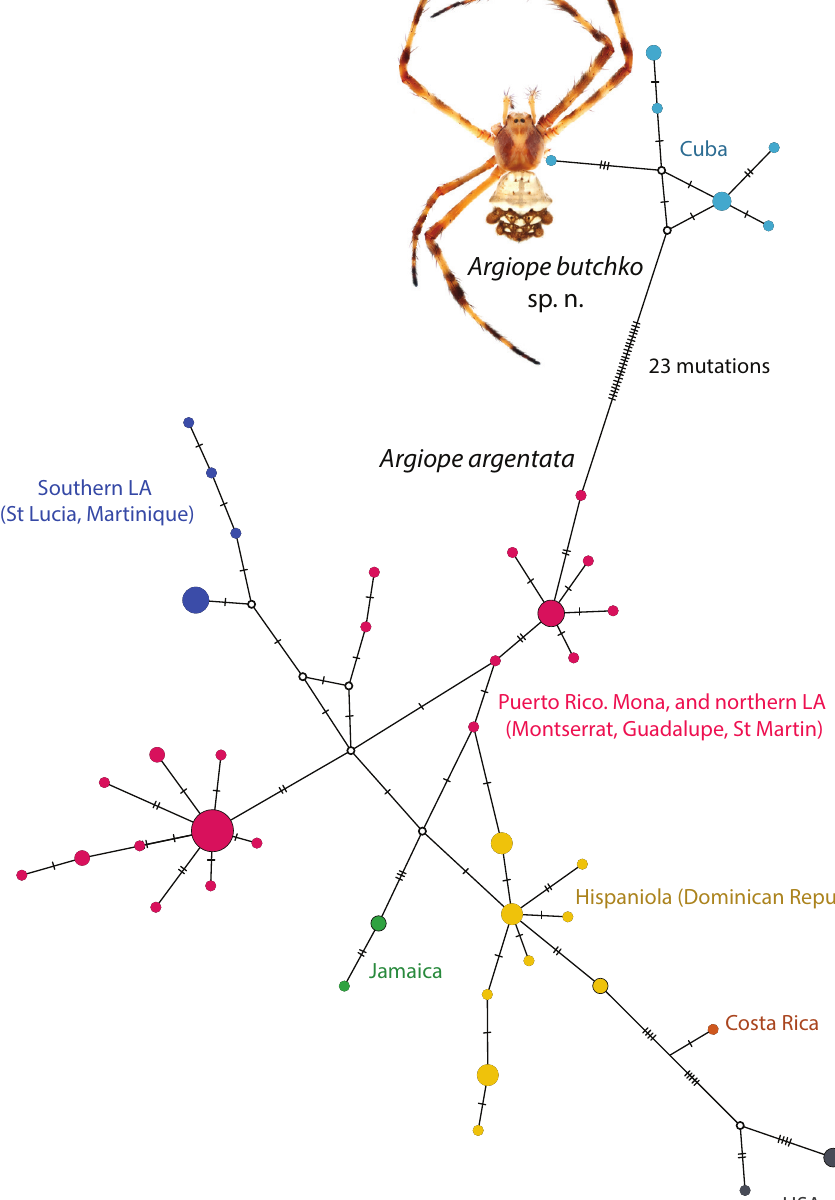
Figure 3. A haplotype network of Caribbean A. argentata and A. butchko sp. n. Haplotypes are colored by locality as indicated, circle size reflects number of individuals carrying that haplotype from 1-7 in total, open circles represent unobserved haplotypes. Hash marks indicate mutational differences among haplo- types. Inset photograph is of a female A. butchko